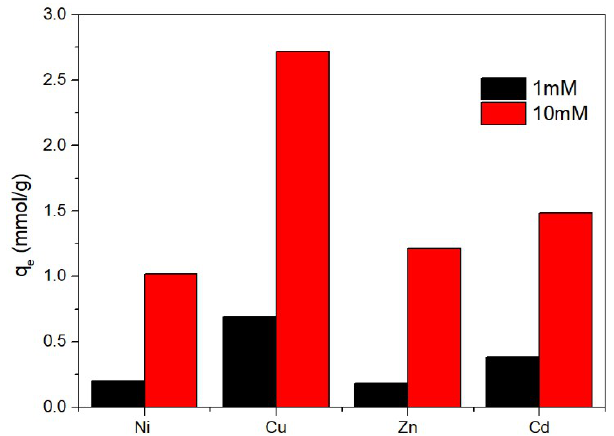
Figure 9. Effect of Cu(II) competitive adsorption in a quaternary metal system. Reaction conditions: T = 293 K, pH = 5, [Cu(II)] 0 = [Zn(II)] 0 = [Ni(II)] 0 = [Cd(II)] 0 = 1mM/10mM, reaction time = 12 h.